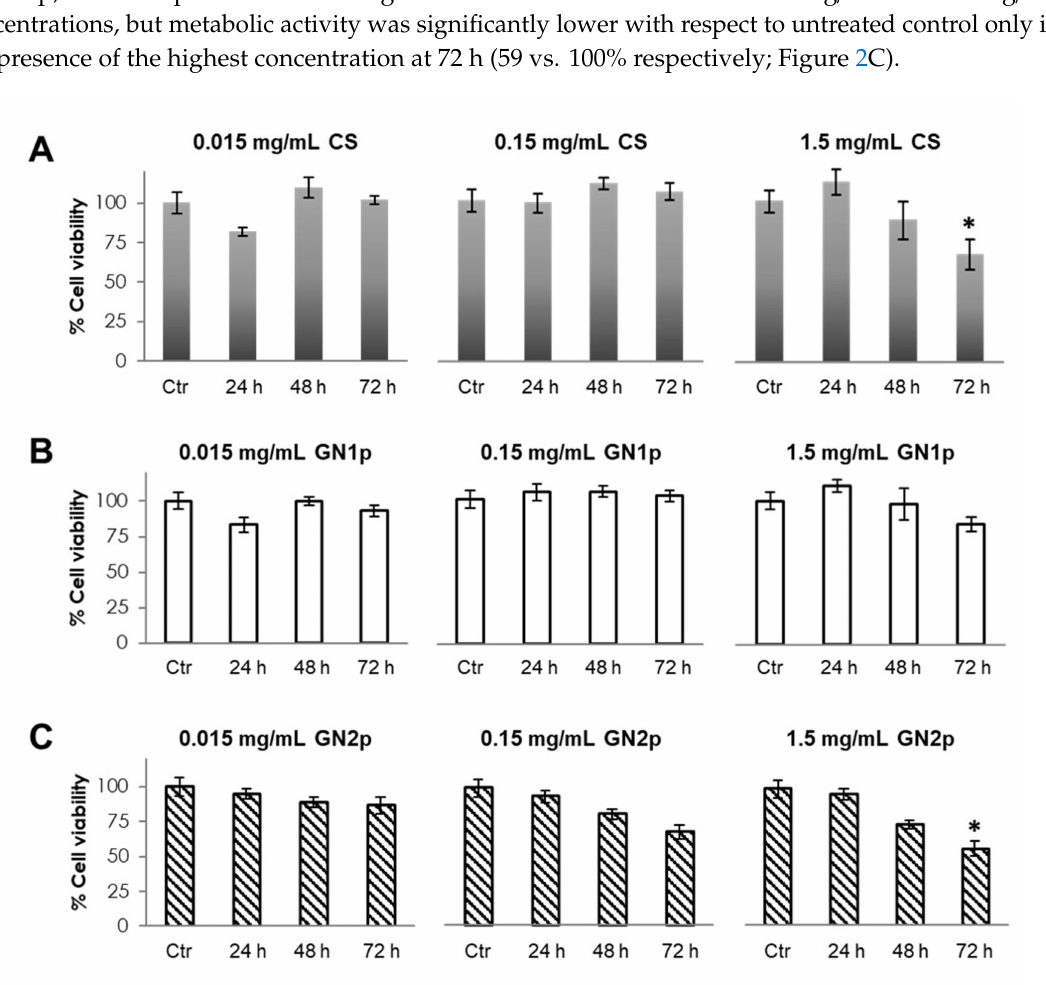
Figure 2. Analysis of the viability of MG63 cells in the presence of the CS, GN1p and GN2p powders. MTT assays were performed on MG63 cells cultured in the presence of serial dilutions (1.5, 0.15 and 0.015 mg / mL) of ( A ) CS powder, ( B ) GN1p and ( C ) GN2p at di ff erent time points (24, 48 and 72 h). Data are reported as mean values from n = 6 biological replicates and are expressed as % viability ( ± S.E.M.) with respect to the untreated control cells (Ctr) at each time point. Statistical analysis was assessed by a Student’s t -test (* p <